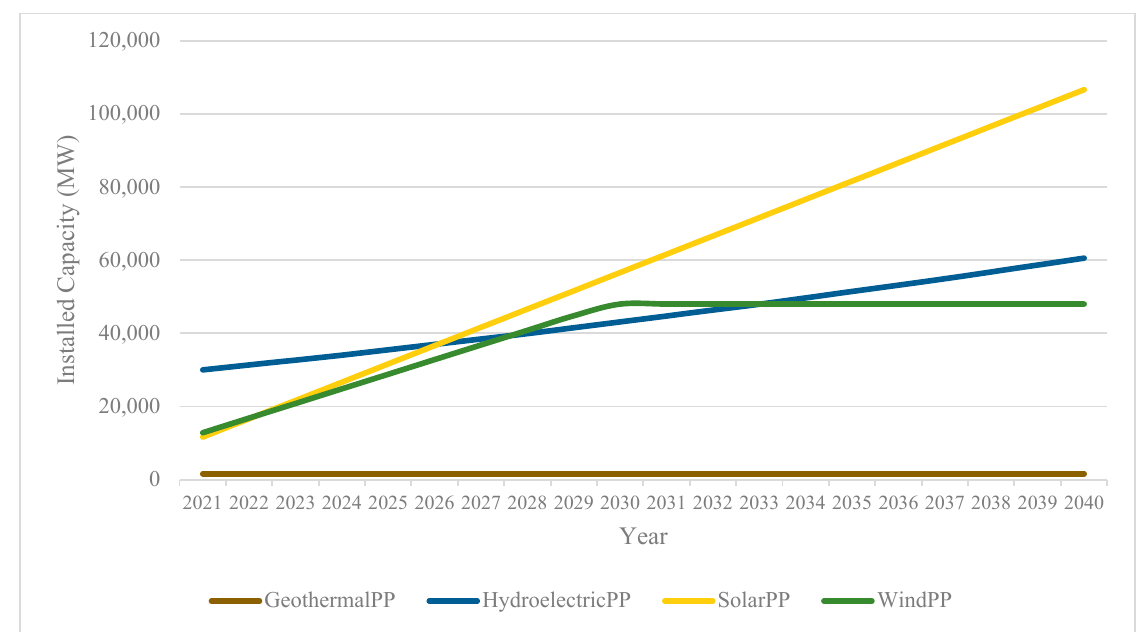
Figure 8. Installed capacities for the third scenario in the 2021–2030 horizon.